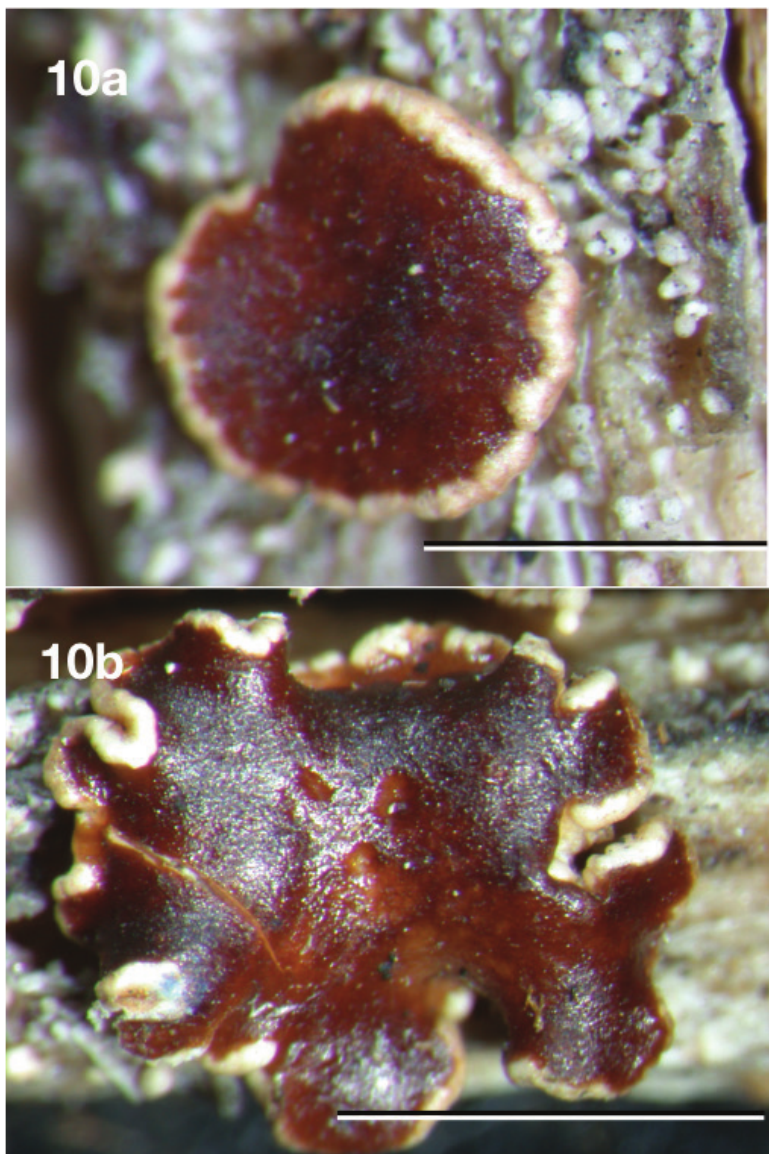
Figure 10. Neoprotoparmelia isidiata , holotype Aptroot 31494 (BR). Scale bar: 1 mm.